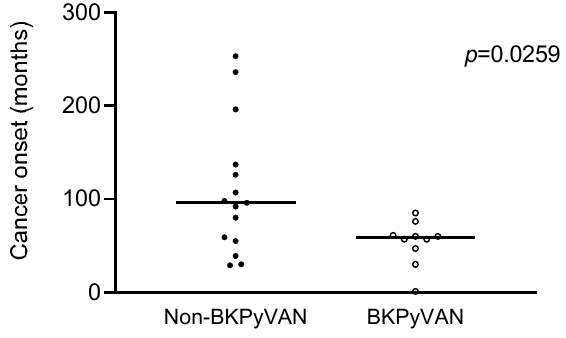
Figure 3. Comparison of the onset of urinary tract cancers after kidney transplantation between patients with and without BKPyVAN. The onset of 10 urinary tract cancers (5 from our hospital and 5 from Taichung Veteran General Hospital) after kidney transplantation in patients with BKPyVAN was compared to that in patients without BKPyVAN by Student’s t -test.